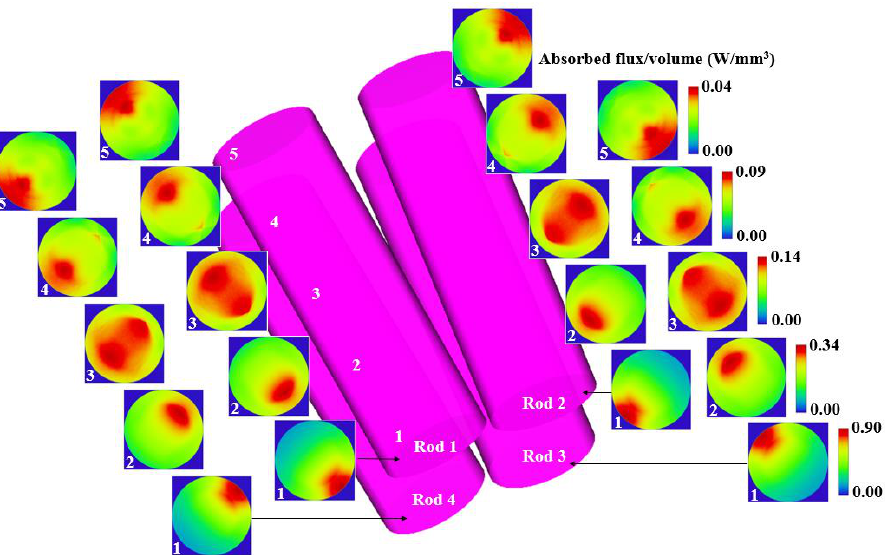
Figure 3. Absorbed pump-flux distributions along five transversal cross-sections (1,2,3,4 and 5) of the four Nd:YAG rods.